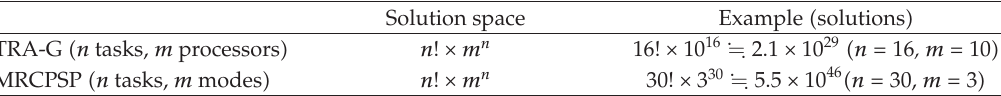
Table 14: Complexity of the scheduling problem. Solution